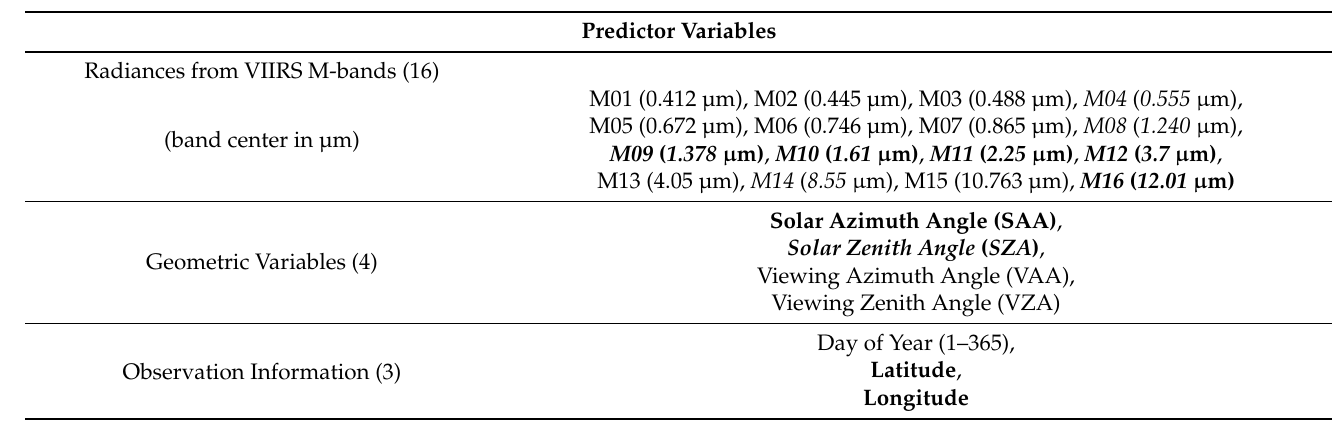
Table 2. Predictor variables used in the study based on VIIRS measurement. Variables marked in bold represent the top nine features selected by RF, and variables marked in italic represent the top nine features selected by